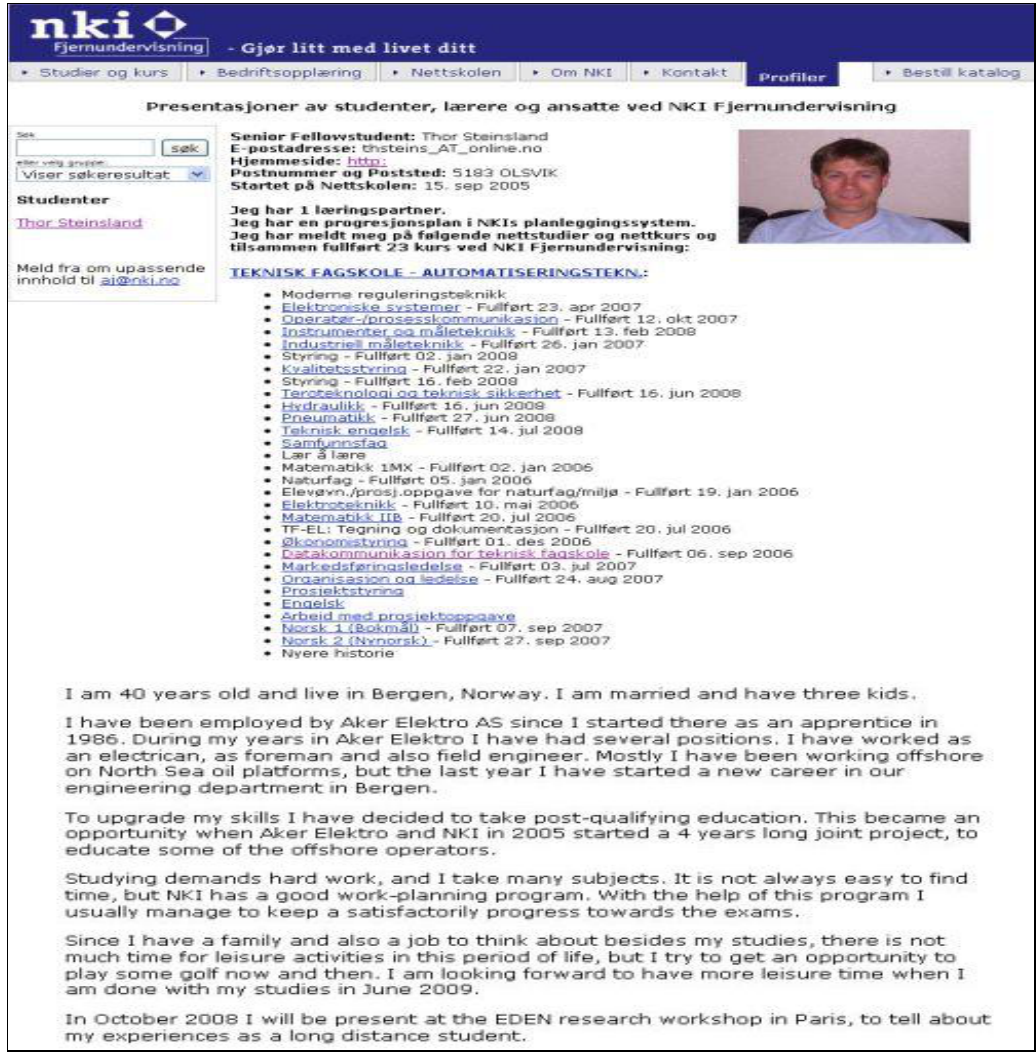
Figure 4 . A personal presentation of an NKI student. Included with permission from Thor